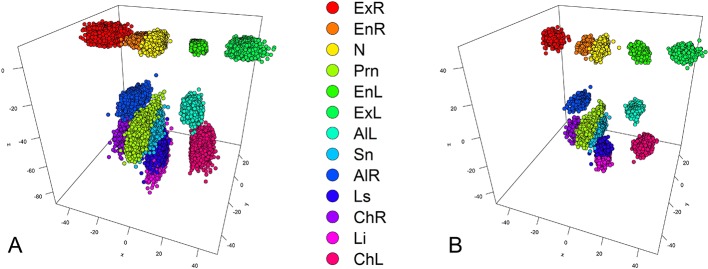
An example of GPA, facial landmarks obtained from 3dMD images in 3193 participants from the discovery cohorts RS.(A) All raw landmarks before GPA process; (B) after GPA process.